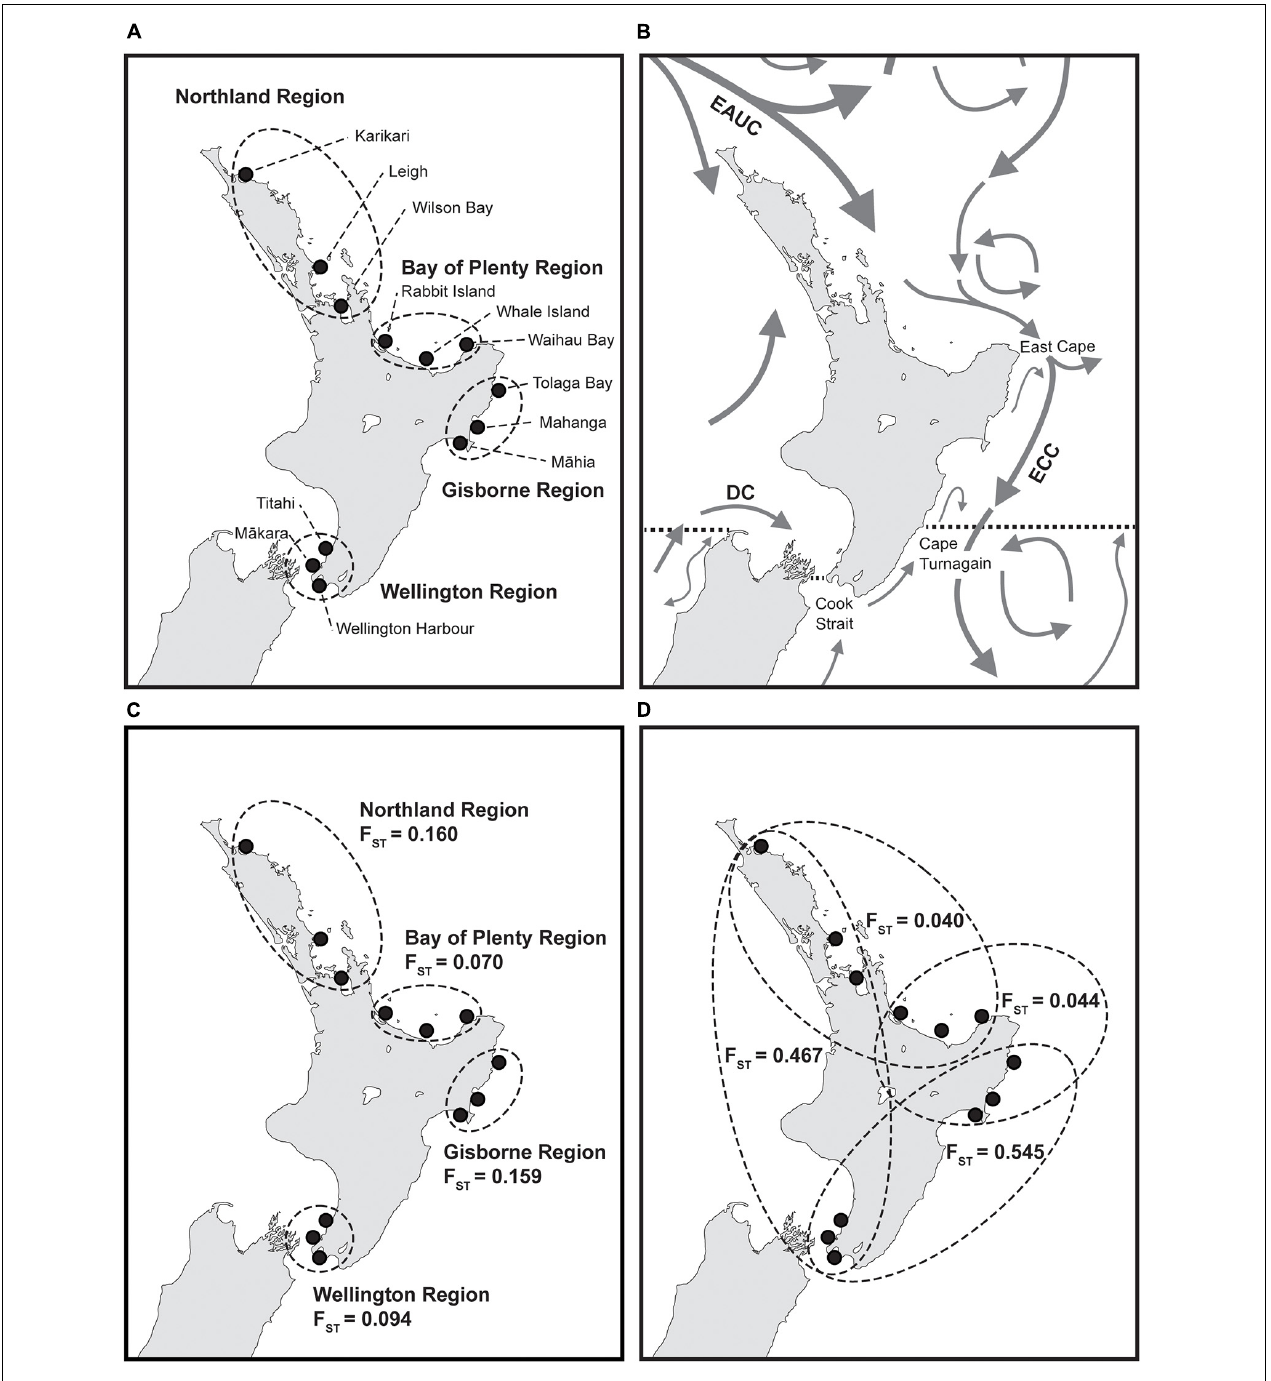
FIGURE 1 | Map of New Zealand with (A) sampling sites (filled black circles) and sampling regions (dashed circles), (B) major ocean currents (Heath, 1985), proposed biogeographic breaks (dashed black lines, Shears et al., 2008) and locations referred to in the text, (C) genetic differentiation (F ST ) of E. radiata within each region and (D) F ST between each neighboring region (F ST Northland vs. Gisborne = 0.043, F ST Bay of Plenty vs. Wellington = 0.407). EAUC: East Auckland Current; ECC: East Cape Current; DC: D’Urville Current. (B) Modified with permission from Buchanan and Zuccarello